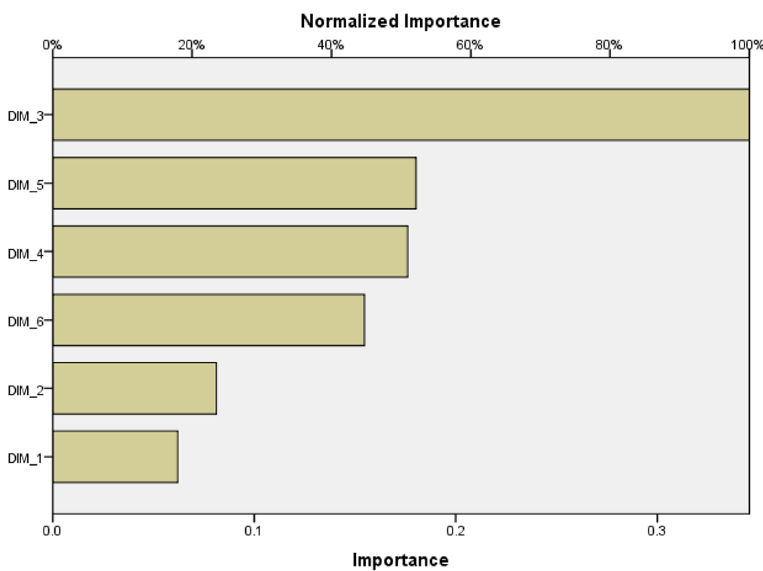
Figure 3. Independent variable